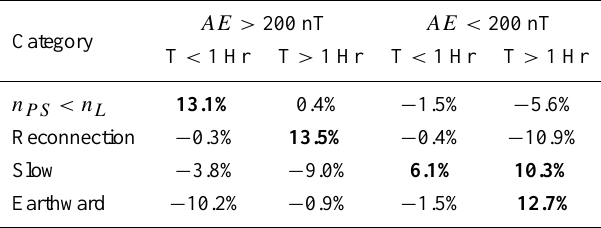
Table 7. Relative differences from expected values with respect to AE index and T from magnetopause crossing: slow flows are more likely to be observed during quiet times close to the magne- topause, and reconnection flows are more likely to be observed in active times in the centre of the magnetotail